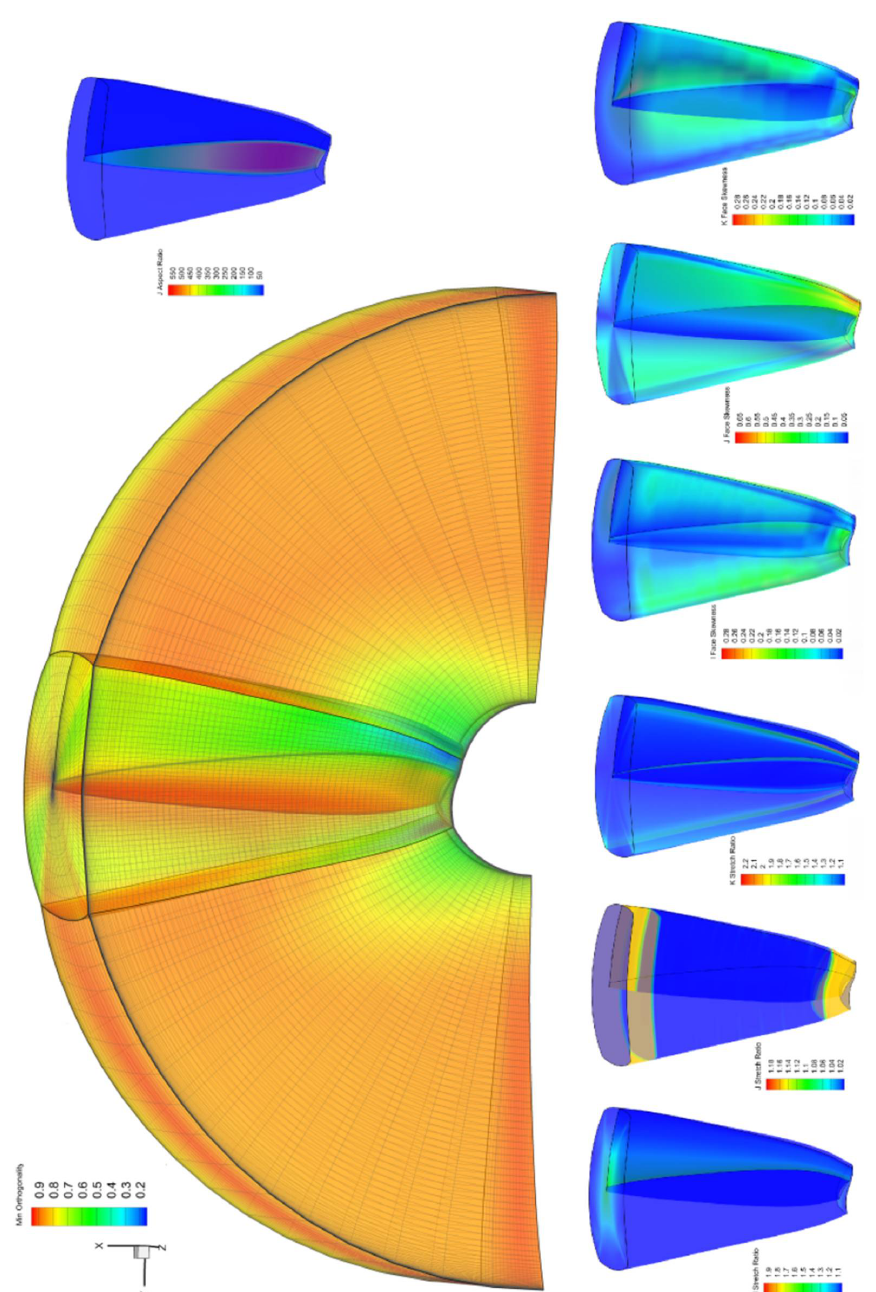
Figure 12. Grid metrics for a representative propeller geometry. Clockwise from bottom left corner is min. orthogonality, J aspect ratio, IJK face skewness and IJK stretch (expansion) ratio.